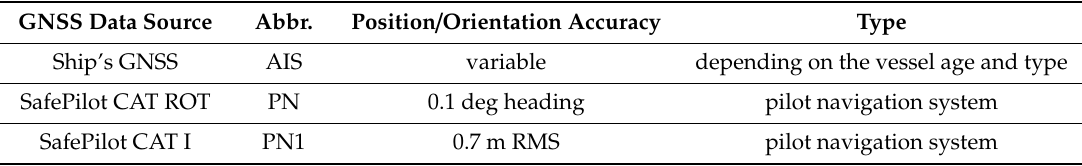
Table 7. Automatic Identification System (AIS) and global satellite-aided positioning system (GNSS) receiver